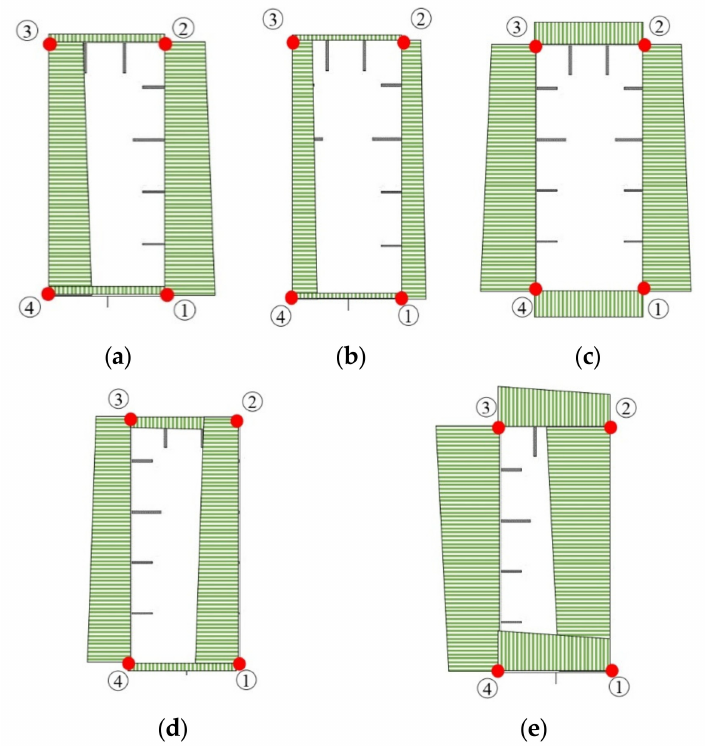
Figure 13. Shear stress distribution induced by ( a ) vertical shear force ( b ) horizontal shear force ( c ) St. Venant torque ( d ) warping torque, and ( e ) warping normal stress induced by warping